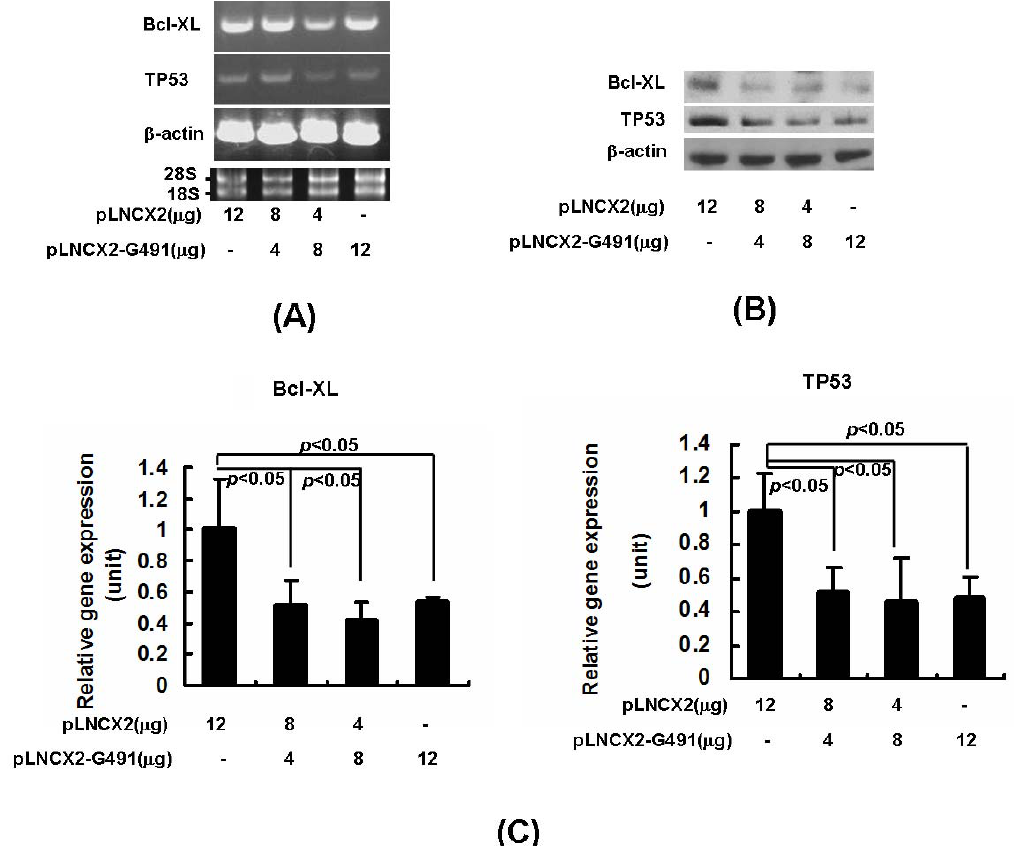
Figure 2. The down-regulation of the targeted gene expressions by plasmid derived miR491-5p in SW1990 cells. ( A ) Semi-quantitatative RT-PCR analysis on endogenous Bcl-XL and TP53 mRNA expressions was performed after transfecting SW1990 cells with increased doses of pLNCX2-G491. The integrity of RNA samples was assessed by gel electrophoresis to visualiz the presence of 18S and 28S RNAs; ( B ) Western blot analysis on pLNCX2-G491 transfected SW1990 cells. The reaction products were probed with anti-Bcl-XL and anti-TP53 antibodies. Beta-actin expression was served as loading control; ( C ) Real time qRT-PCR analysis on Bcl-XL and TP53 gene expressions was shown after delivering increased doses of pLNCX2-G491 into SW1990 cells. Beta-actin gene expression was served as internal control. Data represented as mean ± SD from four independent experiments. The difference was calculated by student’s t test. Significant difference was indicated as p <